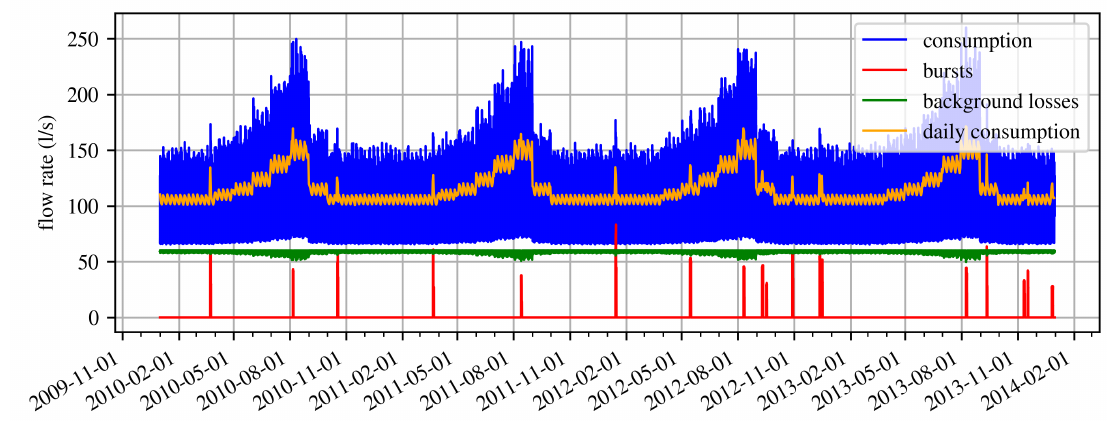
Figure 4. Total consumption of Apulian network generated for a period of four years. The plot also displays the bursts, the background losses, and the average daily